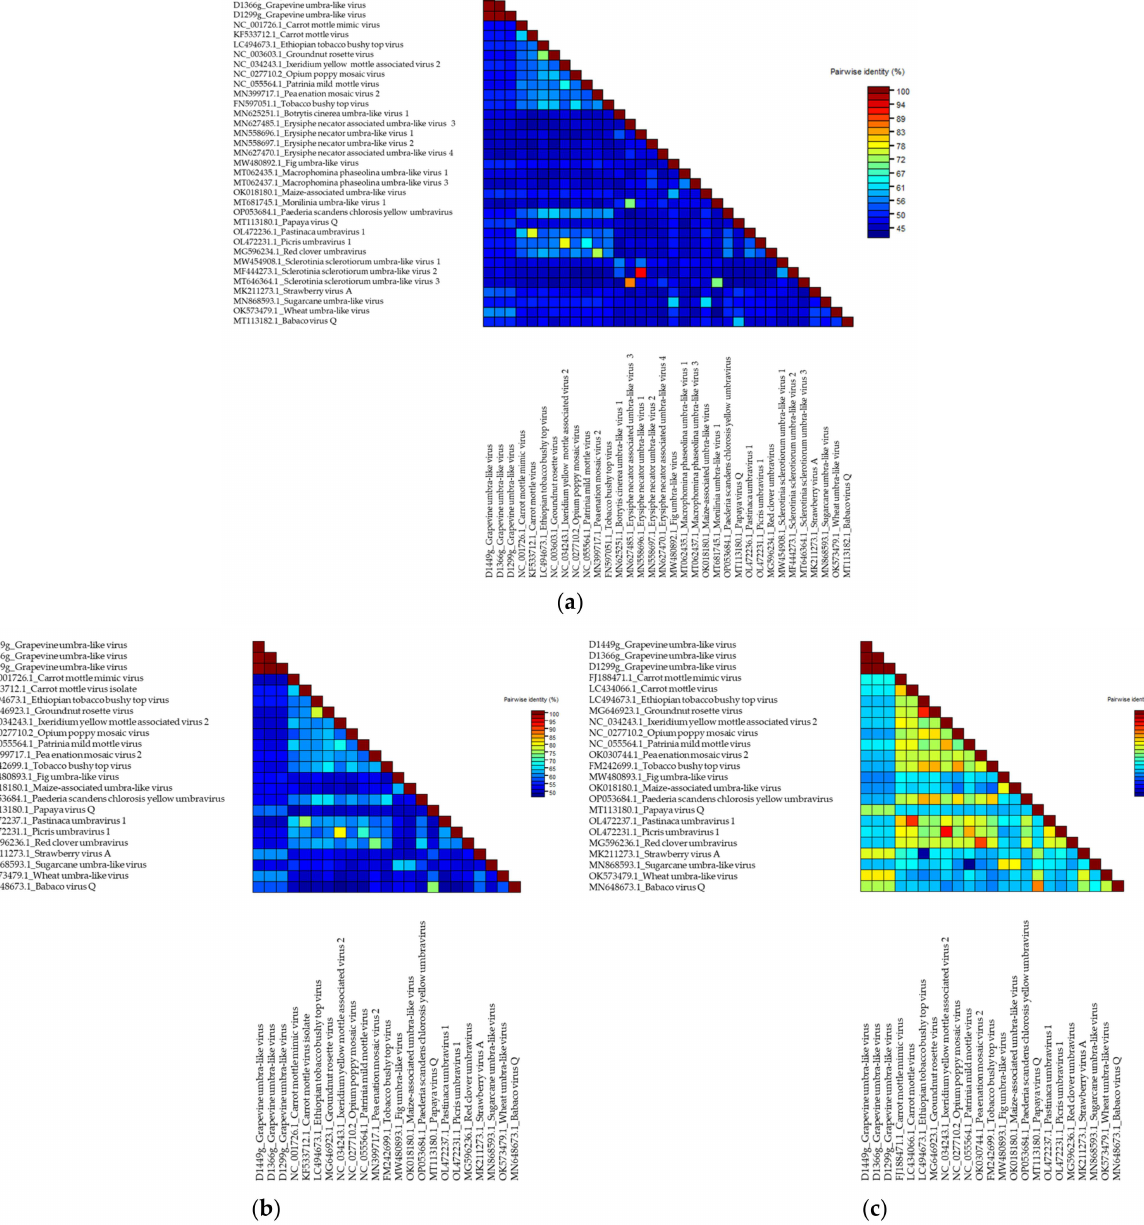
Figure 2. Color-coded pairwise identity matrix including ( a ) complete genomes, ( b ) nucleotide sequences of the RNA-dependent RNA polymerase (RdRp), ( c ) amino acids sequences of the RdRp of grapevine umbra-like virus isolates, representative isolates of the genus Umbravirus and unclassified umbra-like viruses. GenBank accession numbers for each isolate are present by virus isolate names and are also in Supplementary Table